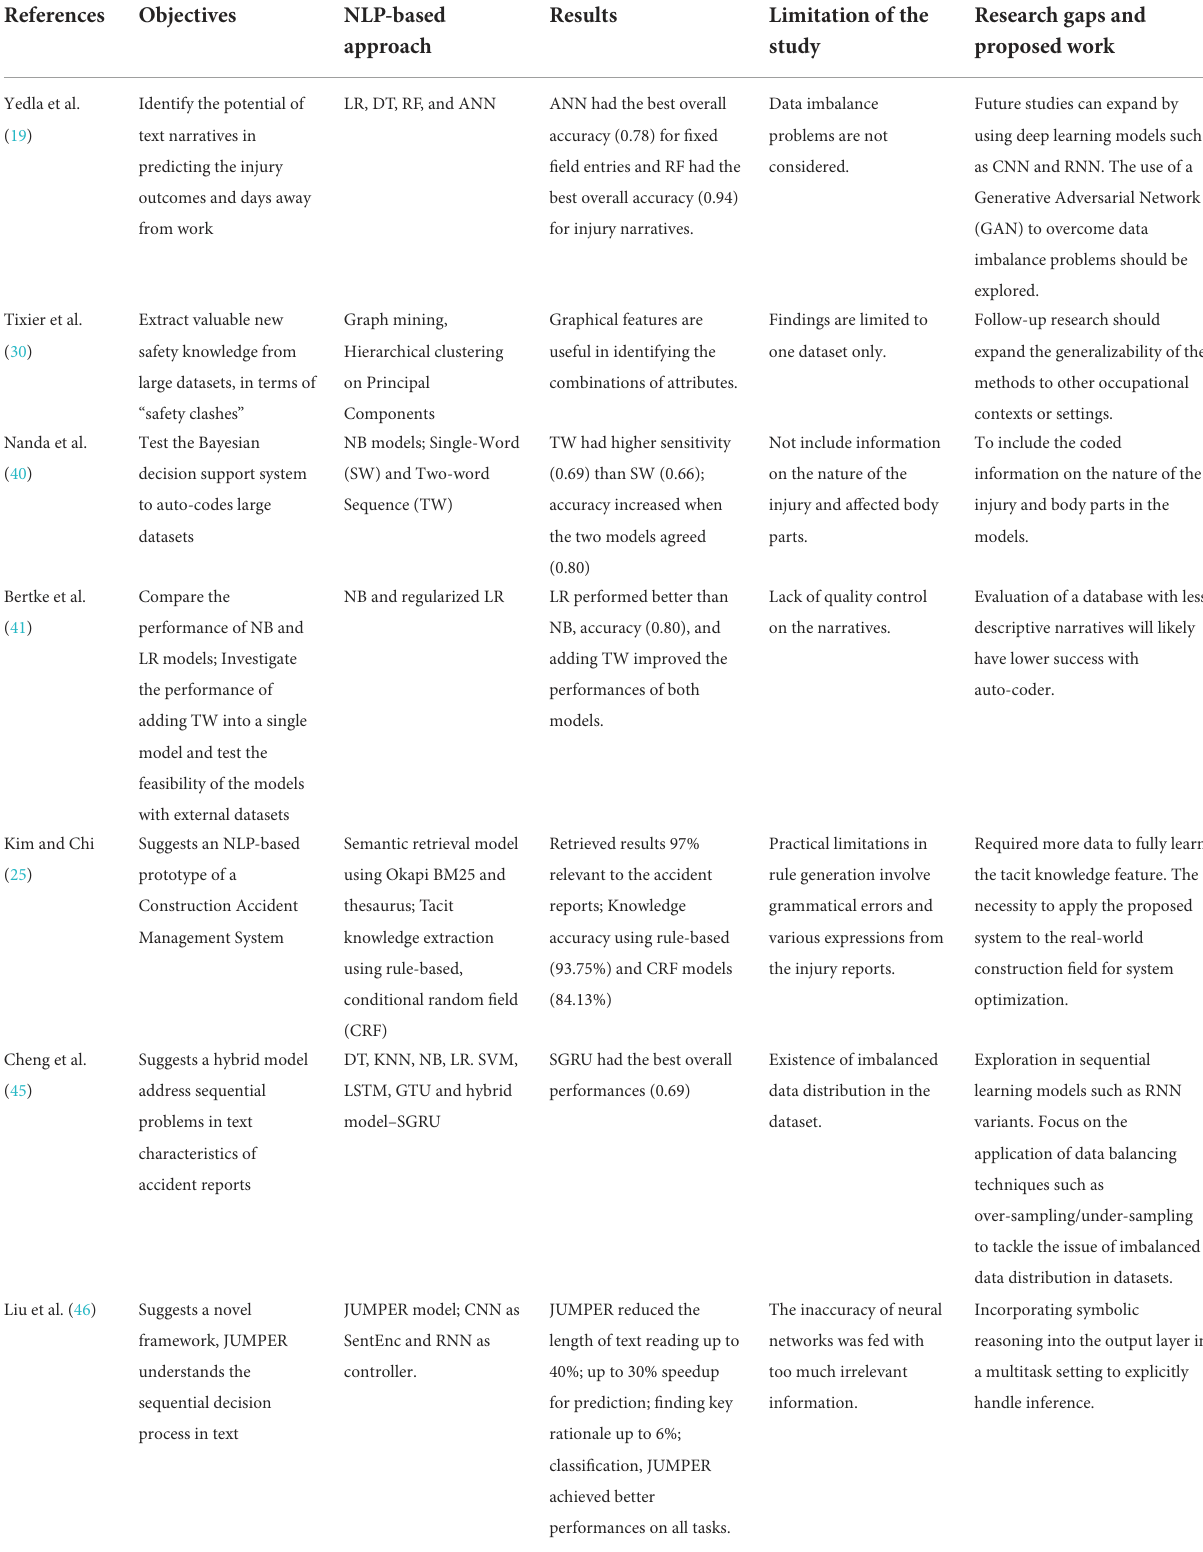
TABLE 4 Short Summary of review